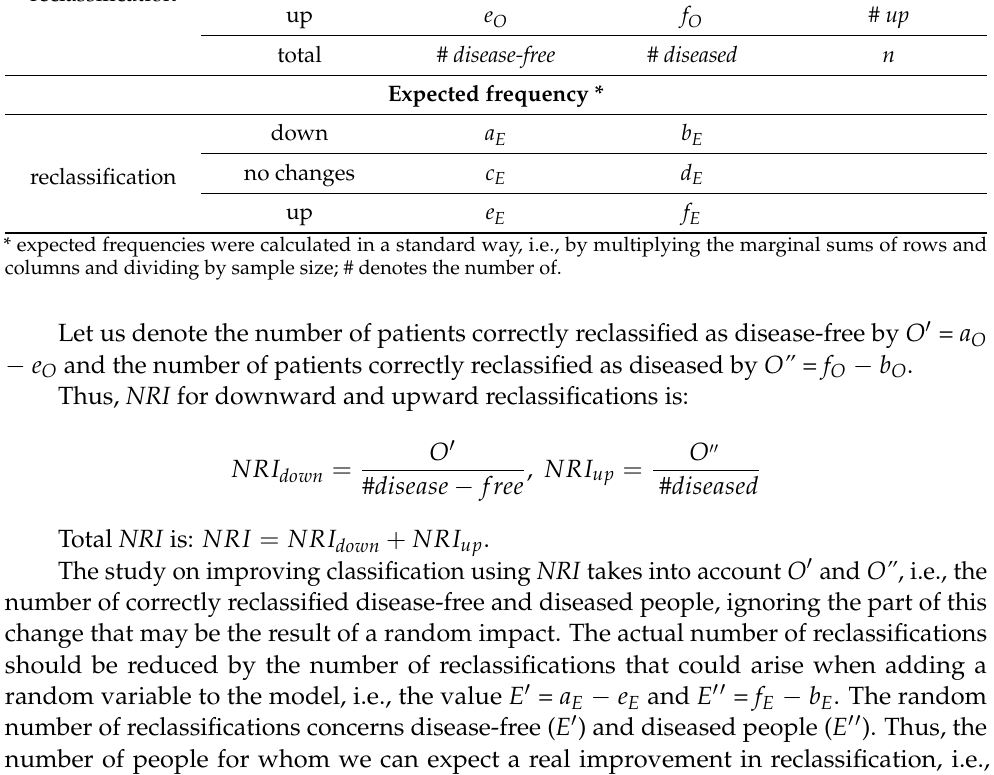
Table 1. Observed reclassification to a group of people who were diagnosed with a disease and a group of disease-free individuals, and the numbers expected for random reclassification. Observed Frequency disease-free diseased total down a O b O # down c O d O # no changes reclassification f O #